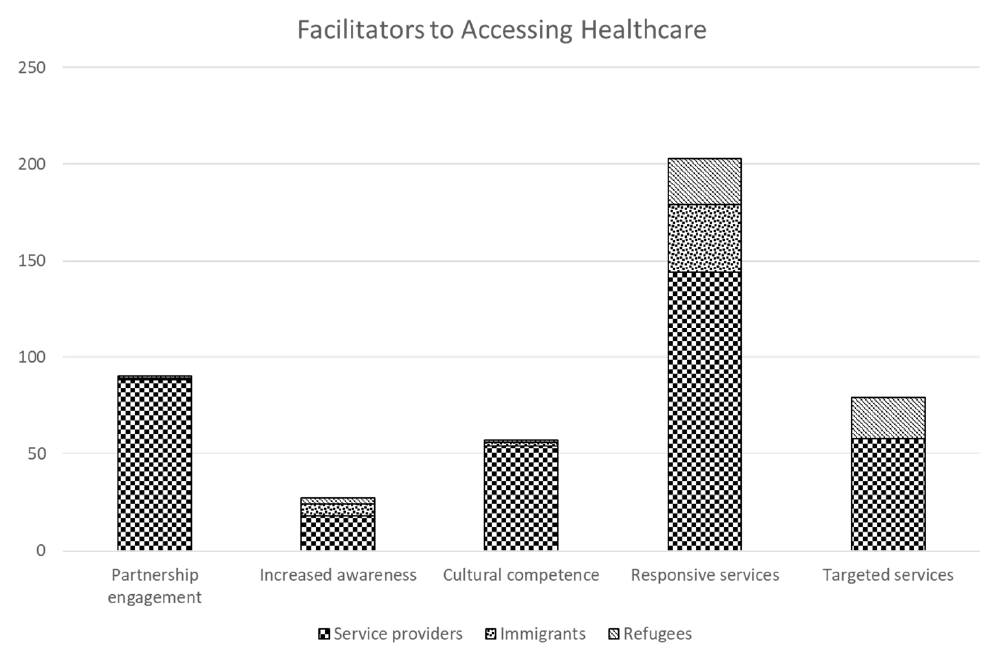
Figure 1. Frequency of data extracts coded to themes by interviewee type.